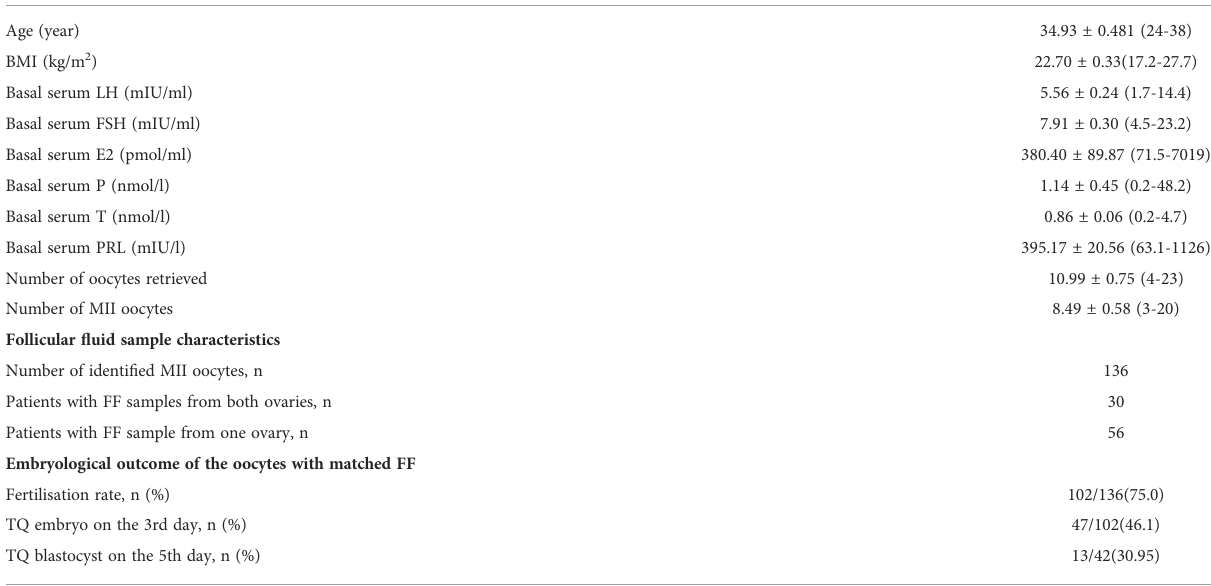
Patients clinical